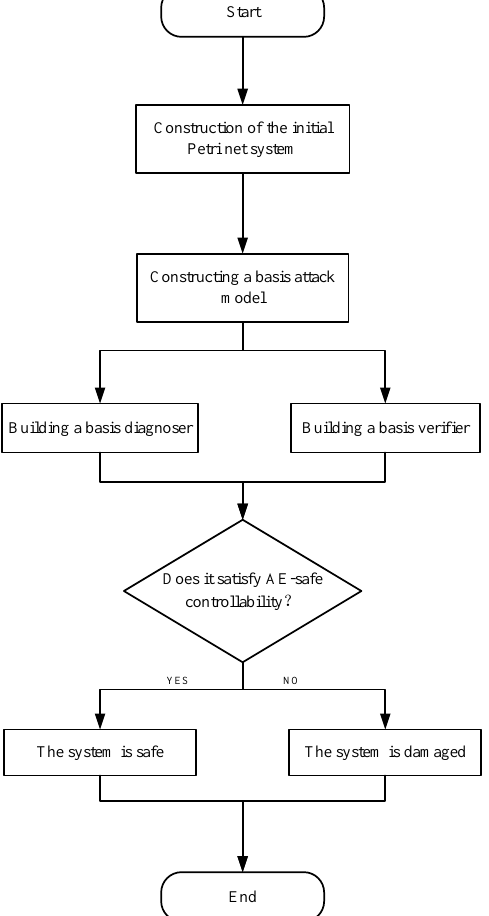
Figure 3. The flowchart of AE-attack